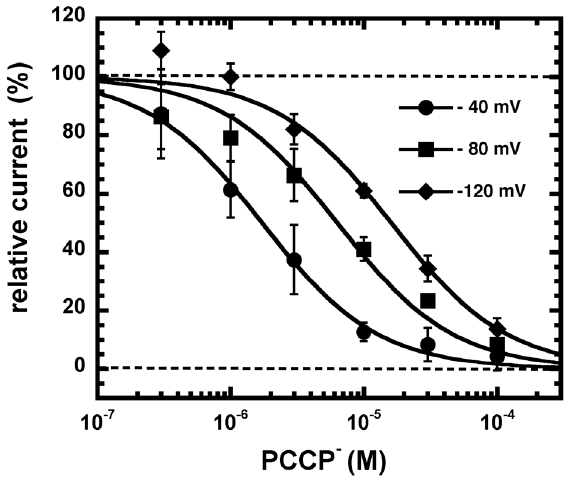
Figure 5. Effect of the membrane potential on inhibition by PCCP 2 . A, GABA A receptors were activated with a concentration of GABA eliciting 10% of the maximal current amplitude (EC 10 ) and inhibited with increasing concentrations of PCCP 2 . Averaged concen- tration inhibition curves by PCCP 2 are shown for different membrane potentials. Individual curves were fitted and standardized to the current elicited by GABA. Data are shown as mean 6 SD (n=3).